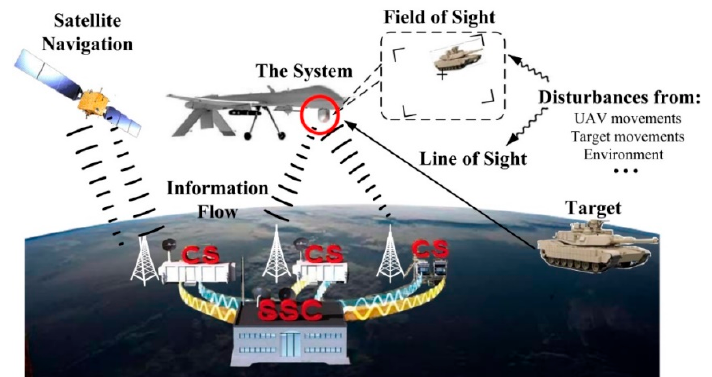
Figure 1. Typical application scenario of UAV photoelectric detection system.